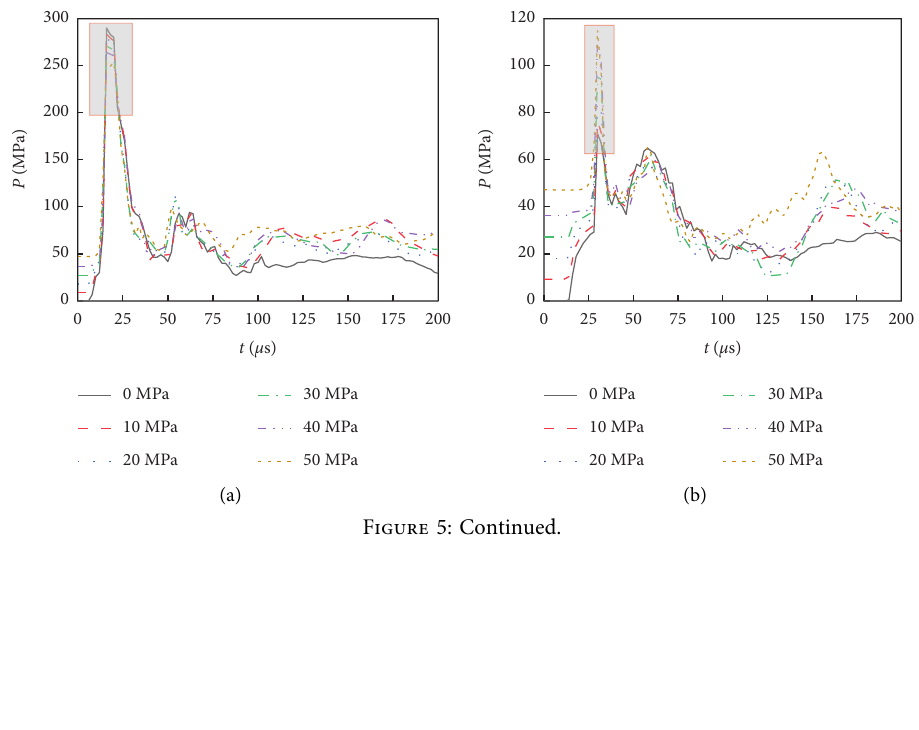
� σ � 0 MPa. (b) σ � σ � 10 x y x y